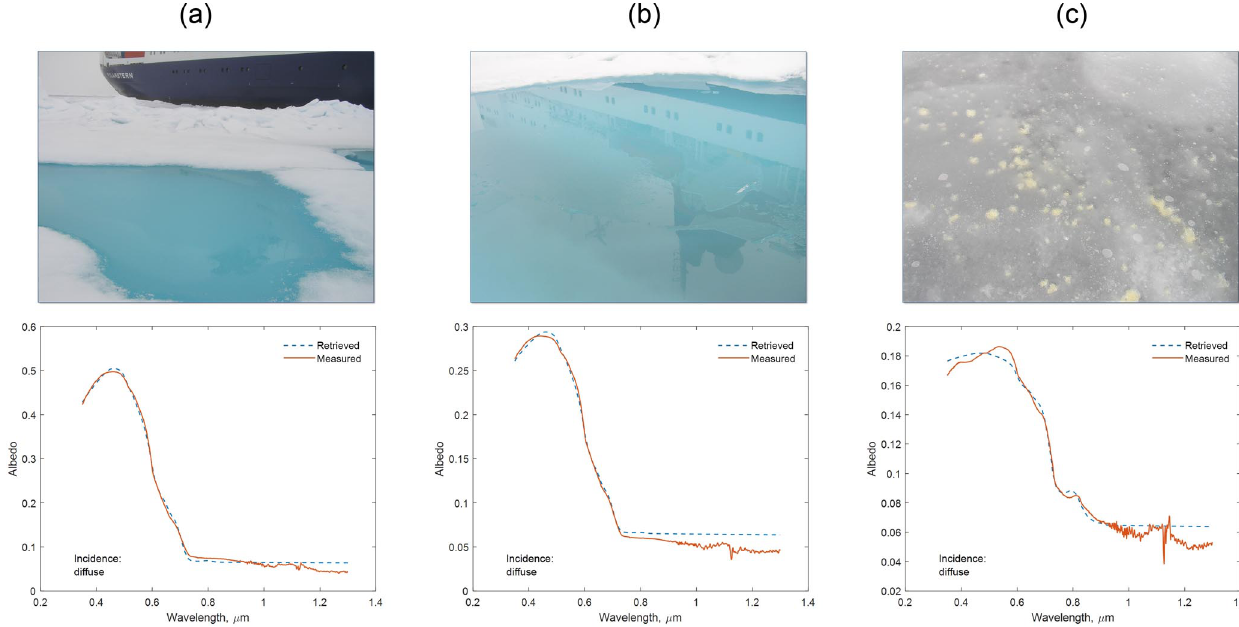
Figure 9. (a) The light-blue pond, (b) a darker part of the blue pond, and (c) the dark pond with yellow algae. Polarstern-2012, Stations 4.